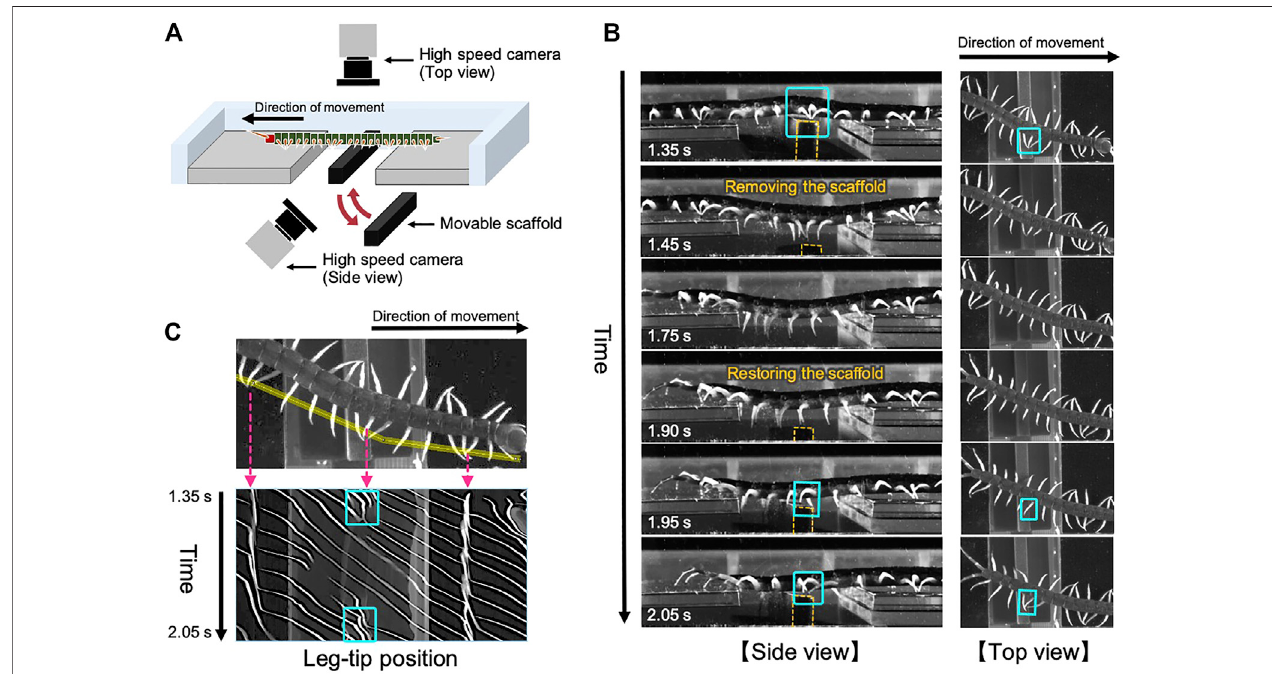
FIGURE 1 | Adaptive centipede walking when part of the terrain was temporarily removed and subsequently restored during locomotion. (A) Schematic of the experimental setup. (B) Snapshots of the observed walking from the side and top views. All the snapshots are mirror images of their original ones. In the original movies (Supplementary movies S1 and S2), the direction of movement was from the right to the left. Orange dashed lines indicate the contour of the moving scaffold. (C) Spatiotemporal plots of the tip positions of the left legs along the body axis. Yellow line in the upper fi gure denotes the cropped line we used for the analysis. Cyan squares in (B,C) indicate the characteristic behavior observed on the moving scaffold that the posterior legs trail the ground contact point of the nearest anterior legs.